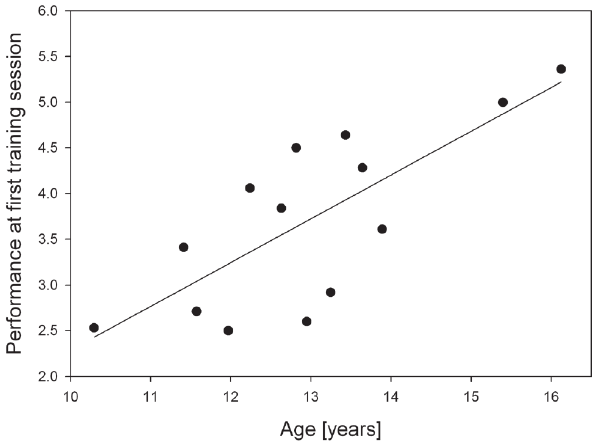
Figure 3. Age at the first training session. Correlation between age (years) and performance at the first session of visuospatial n-back training (Pearson correlation, r = 0.76, p < 0.05).